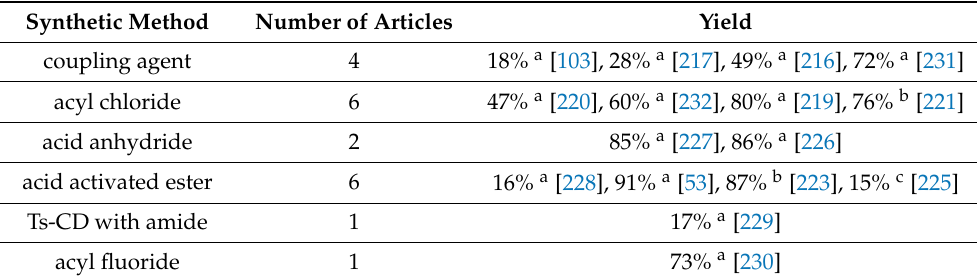
Table 9. Preparation of 6 A - N -Acyls of CDs. Synthetic